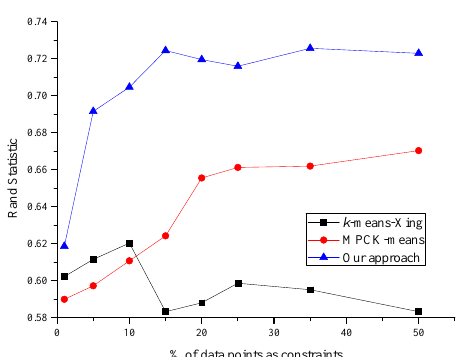
Fig. 6. Clustering accuracy versus constraints on Iono-